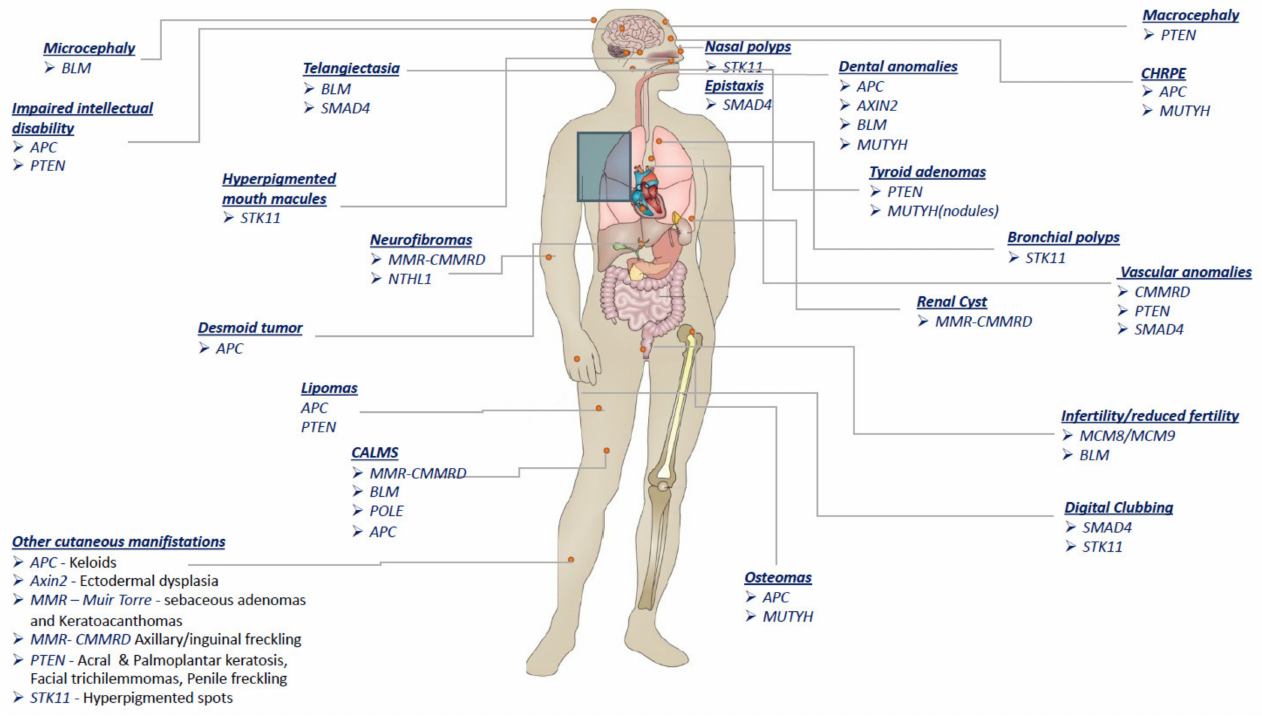
Figure 1. Graphical image of the various benign features associated with the predisposition colon cancer